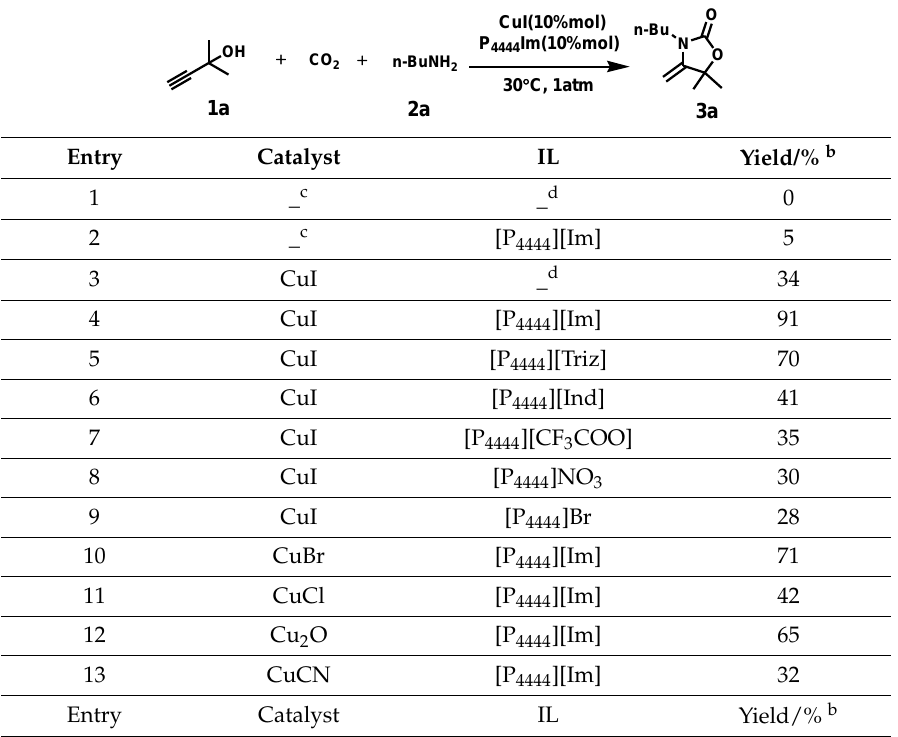
Table 1. Reaction of 2-methyl-3-butyn-2-ol ( 1a ), n -butylamine ( 2a ) and CO 2 in various catalyst systems a .